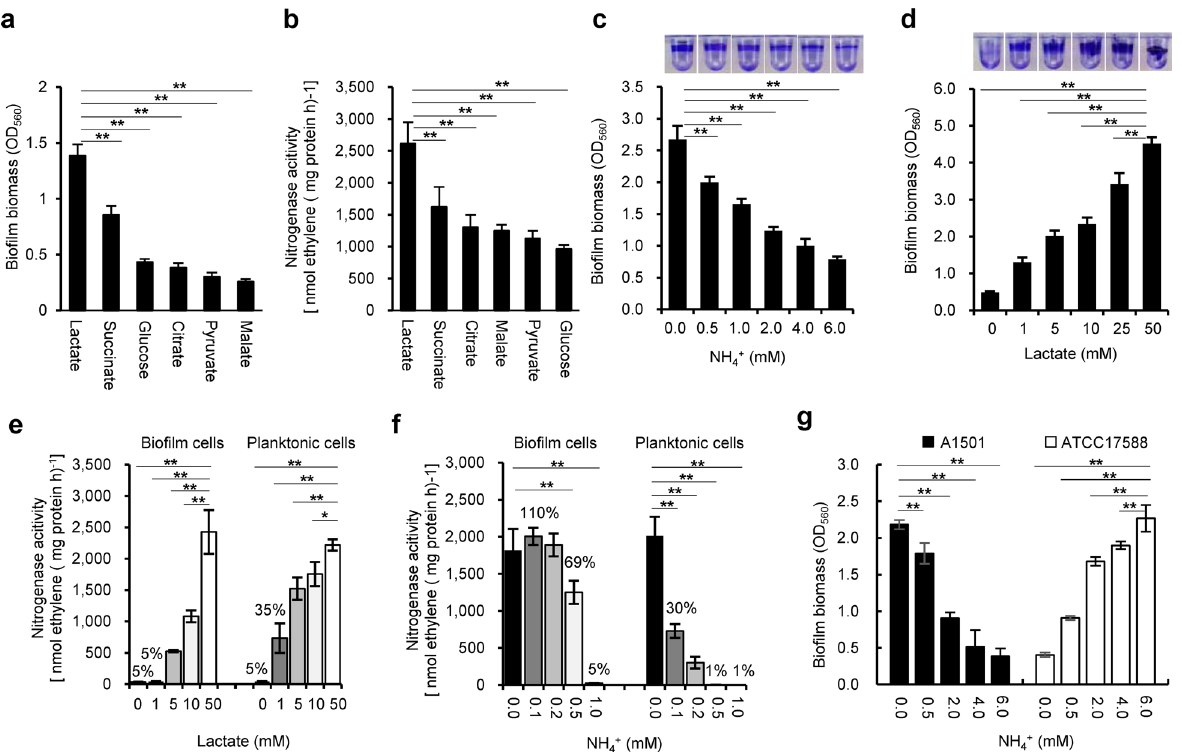
Fig. 1 Nitrogen- fi xing bio fi lm formation. a Effect of different carbon substrates on the mature bio fi lm biomass determined 48 h after inoculation by the crystal violet (CV) method: bacteria were inoculated in minimal medium K devoid of a nitrogen source and containing the carbon substrates at 50 mM. b Effect of the different carbon substrates on the nitrogenase activity under the same conditions as in a . c Effect of NH 4 + concentration (0 – 6.0 mM) on bio fi lm biomass under the same conditions as in a . CV staining of the bio fi lm obtained is shown at the top. d Effect of lactate concentration (0 – 50 mM) on bio fi lm biomass under the same conditions as in a . CV staining of the bio fi lm obtained is shown at the top. e Effect of lactate concentration (0 – 50 mM) on nitrogenase activity under planktonic growth (with shaking at 220 r.p.m. and 0.5% oxygen) and bio fi lm growth conditions (without shaking in air). f Effect of NH 4 + concentration on the nitrogenase activity of the planktonic and bio fi lm cells in minimal medium K containing 50 mM lactate. g Effect of NH 4 + concentration on bio fi lm formation by diazotrophic and non-diazotrophic P. stutzeri strains in minimal medium K containing 50 mM lactate. Unlike A1501, the non-diazotrophic strain ATCC17588 favoured bio fi lm formation under nitrogen-suf fi cient conditions. Each error bar indicates the standard deviation of three independent experiments. Asterisks indicate statistical signi fi cance by one-way ANOVA with LSD multiple-comparison test: * p < 0.05; ** p <